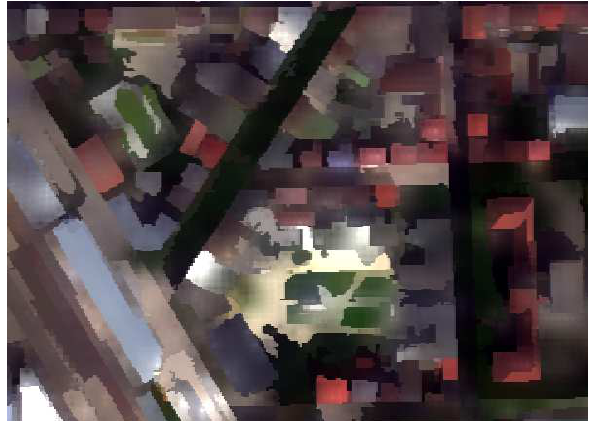
Figure 6: RGB channels of the Segmentation-based Fusion image